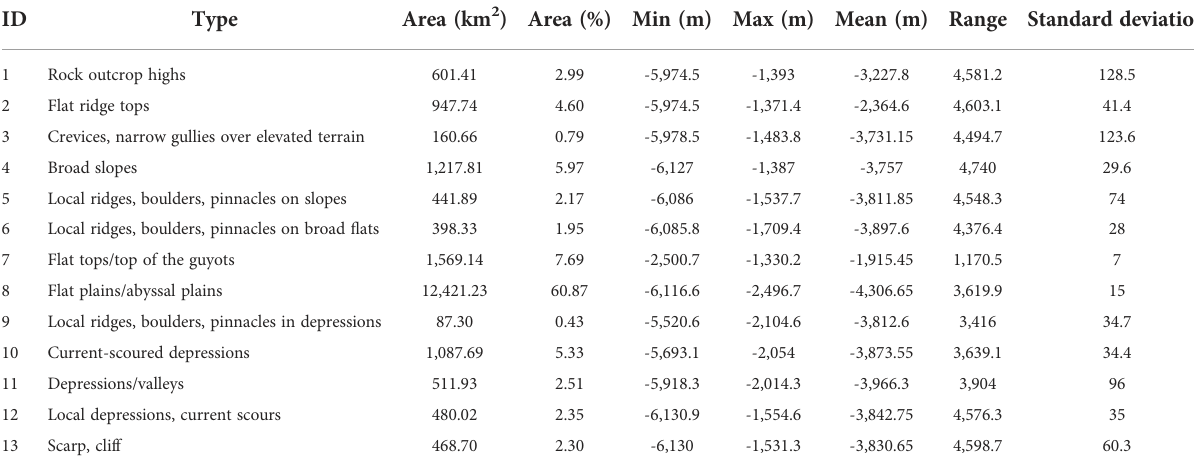
TABLE 4 Statistics of the geomorphological classi fi cation. Structure